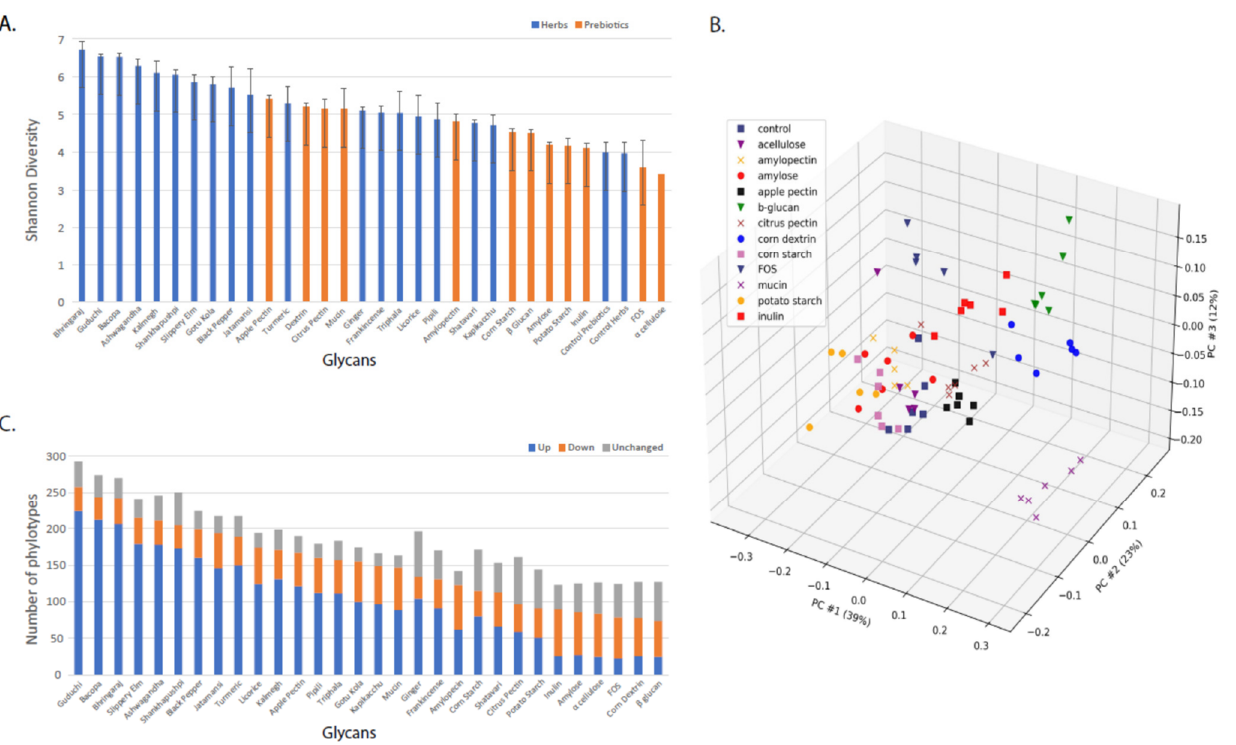
Figure 1. ( A ). Alpha diversity. Shannon diversity measures for control cultures compared to those observed in CDM supplemented with prebiotic fibers (orange) or medicinal herbs (blue). ( B ). Principal component analysis of prebiotic and medicinal herb-supplemented cultures. Bray–Curtis β-diversity measures of control cultures compared to those supplemented with prebiotics and medicinal herbs. ( C ). Comparison of modulatory effects. The average relative abundance of individual taxa in prebiotic and medicinal herb-supplemented cultures was compared to control cultures. Taxa displaying increased or decreased relative abundance (>5-fold) were summed and reported as al- tered.